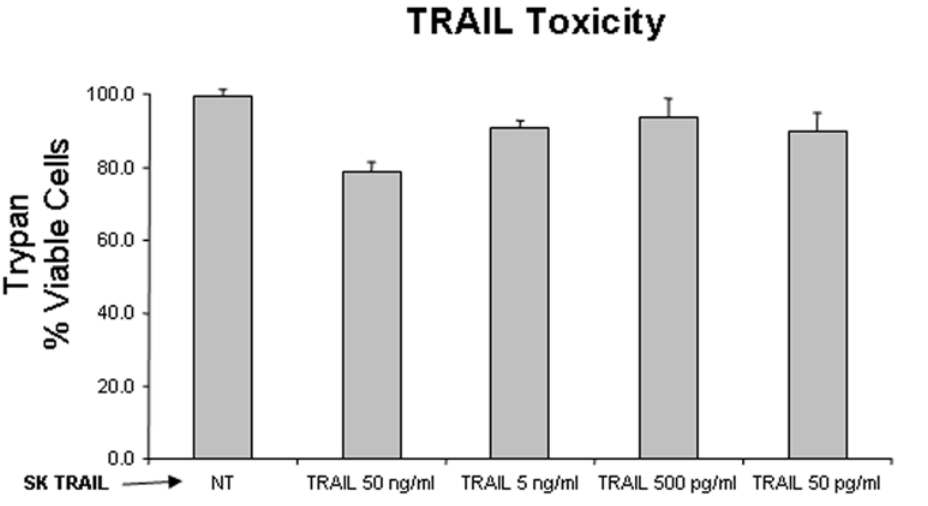
Figure 1. Effect of skTRAIL treatment on cell viability. Peripheral blood lymphocytes (PBLs) were collected from HIV-negative donors, stimulated with PHA and IL-2, and treated with with skTRAIL at the indicated concentrations. Viability was assessed by trypan blue staining.